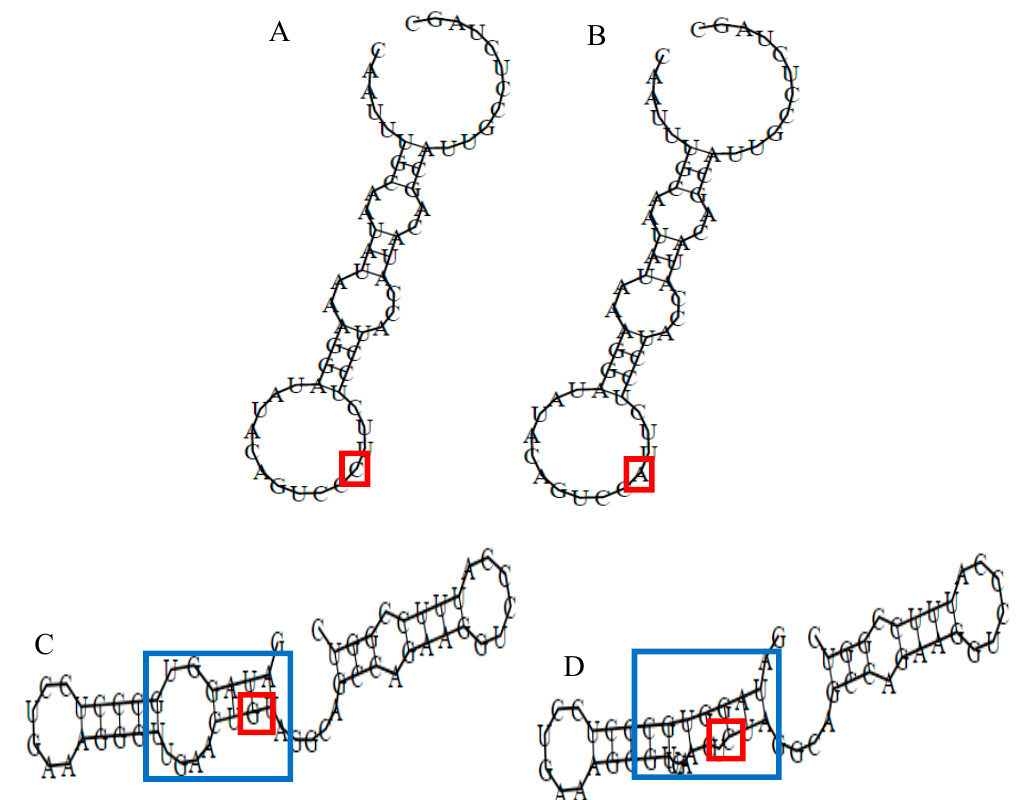
Figure A1. mRNA secondary structures for rs241433 ( A , B ) and rs2071888 ( C , D ). Blue box: Complete conformational change related to the nitrogenous base; Red box: Nitrogenous base